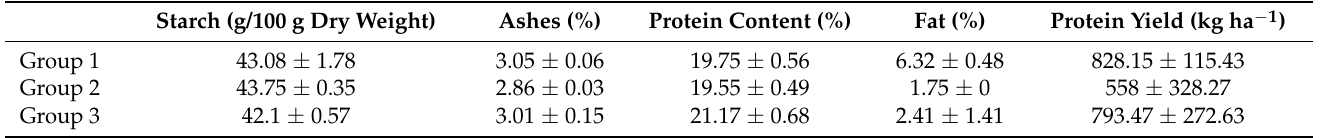
Table 3. Mean Quality Parameters of Three Major Chickpea Groups during the 2017 Growing Season. Starch (g/100 g Dry